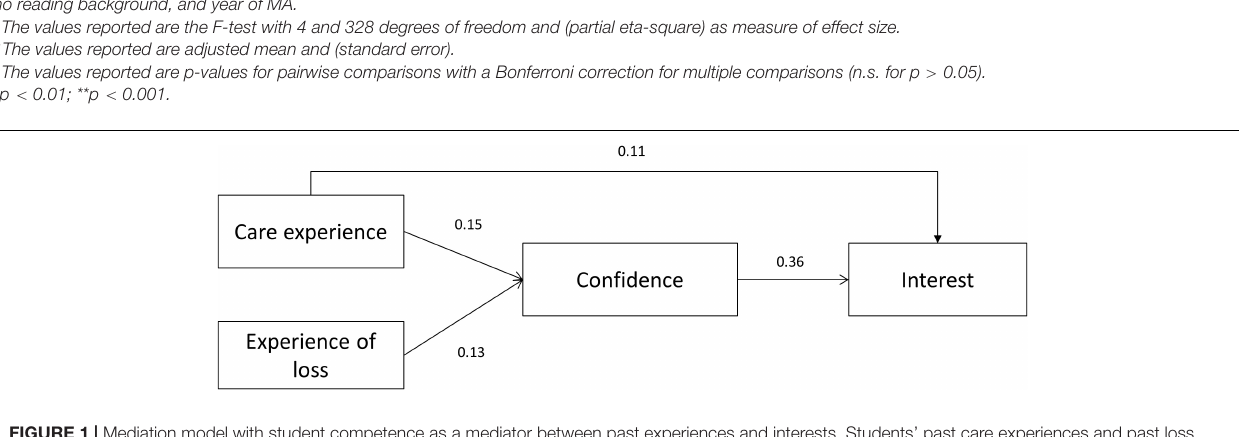
FIGURE 1 | Mediation model with student competence as a mediator between past experiences and interests. Students’ past care experiences and past loss experiences related to students’ current interest in death education and palliative and bereavement care, through the mediation of their sense of confidence in this field. Coefficients presented are standardized linear regression coefficients. Control variables and non-significant paths are omitted for clarity. All p values are <